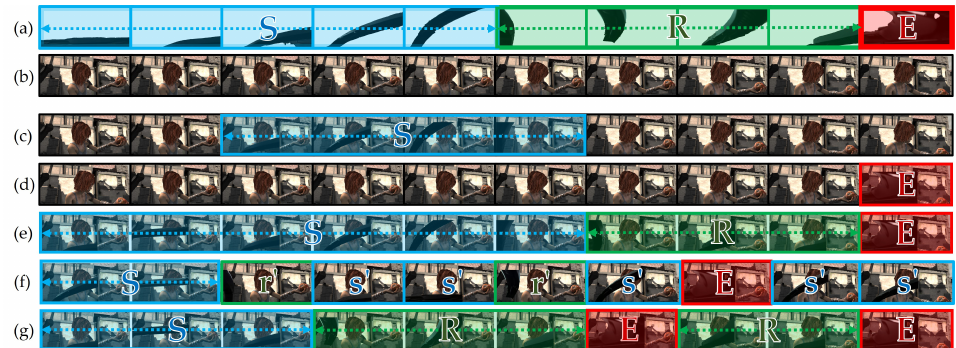
Figure 9. Data synthesis scenario examples: ( a ) original wiper image sequence; ( b ) original Sintel [30]; synthesized with the scenario of ( c ) single sequence ; ( d ) single ending ; ( e ) sequential sequence ; ( f ) random